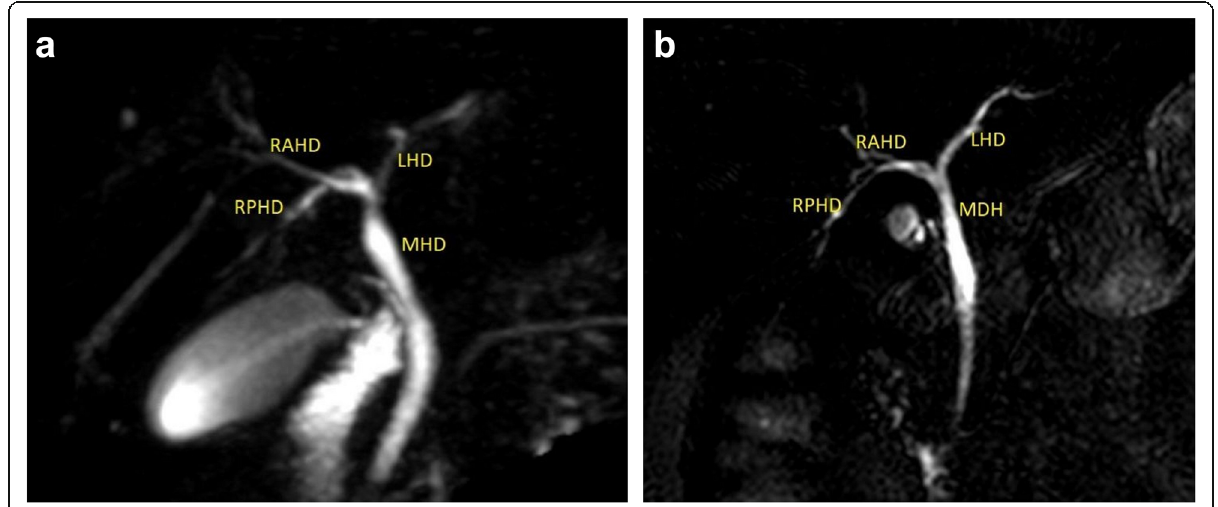
Fig. 4 MRC 3D TSE ( a ) and MRC (RARE) ( b ). Trifurcation (Huang A2): RPHD open into the hepatic common confluence (RPHD, right posterior